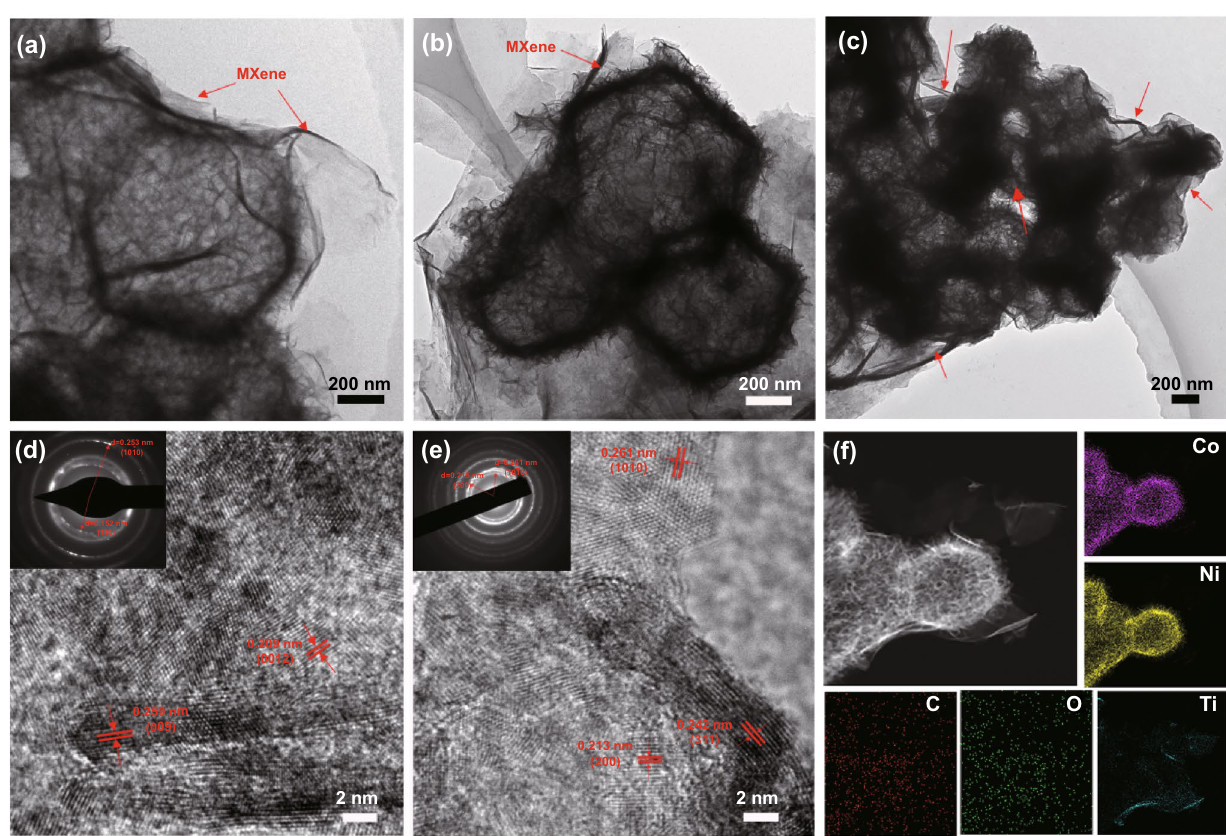
Fig. 3 a TEM and d HRTEM images of LDHT. b, c TEM e HRTEM, and f element mapping images of